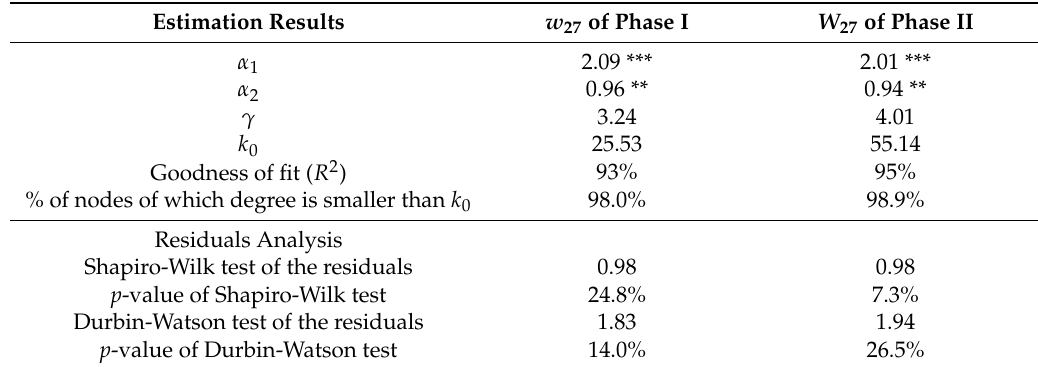
Table 5. Broken power-law estimations.